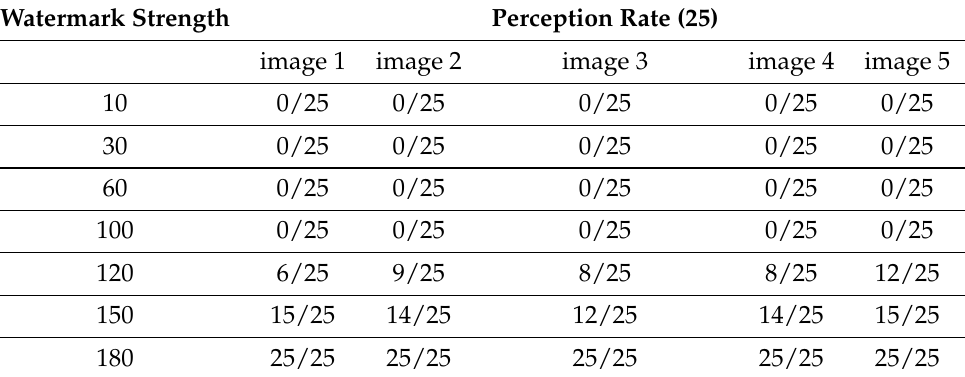
Table 1. Perfectibility of watermarks with different strengths.